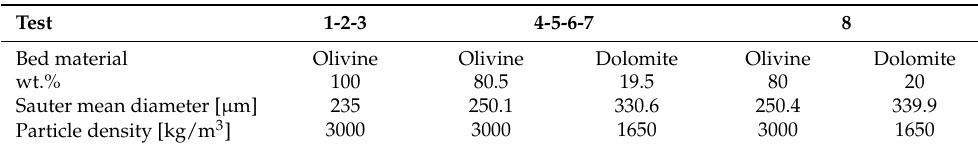
Table 2. Properties of olivine and dolomite